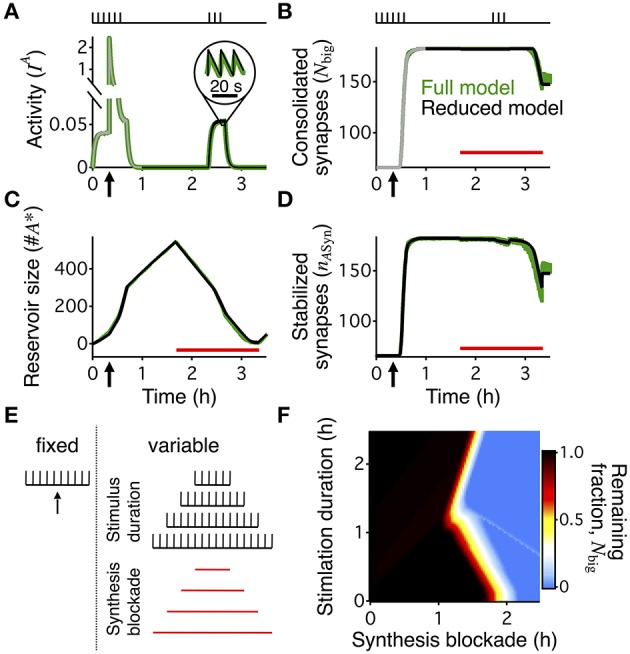
Boundary conditions for reconsolidation mapped using a reduced model. The reduced model (black) approximates the activity averaged across all synapses (A), the number of consolidated synapses (B), the dynamics of the reservoir (C), and the number of stabilized synapses (D) of the detailed write-protected model (green). The stimulation protocol is shown above the plots for (A,B), a red bar shows the duration and timing of the PSI, and an arrow indicates the time of the HFS. For (A,B) the gray line shows the 60 min initiation phase, as simulated with the detailed model. The prediction of the reduced model only begins with the black line after 60 min of simulation. For (A–D) the width of the line indicates s.e.m. (E) A range of conditions to map out when reconsolidation would and would not occur—the “boundary conditions” to reconsolidation. All simulations began with a period of 40 min of background 0.1 Hz stimulation with a HFS at 20 min to induce LTP, as shown to the left of the dotted line. Arrow indicates the time of the HFS. We varied the duration of the following period with no stimulation and the duration of PSI, with examples shown to the right of the dotted line. Stimulation duration and PSI ranged from 0 s to 2.5 h. Both the stimulation and PSI were centered at 150 min. (F) Remaining fraction of consolidated synapses (color code, see scale) at the end of the stimulation protocol relative to the maximal number of consolidated synapses after 60 min for all combinations of different durations of stimulation (vertical axis) and PSI (horizontal axis).